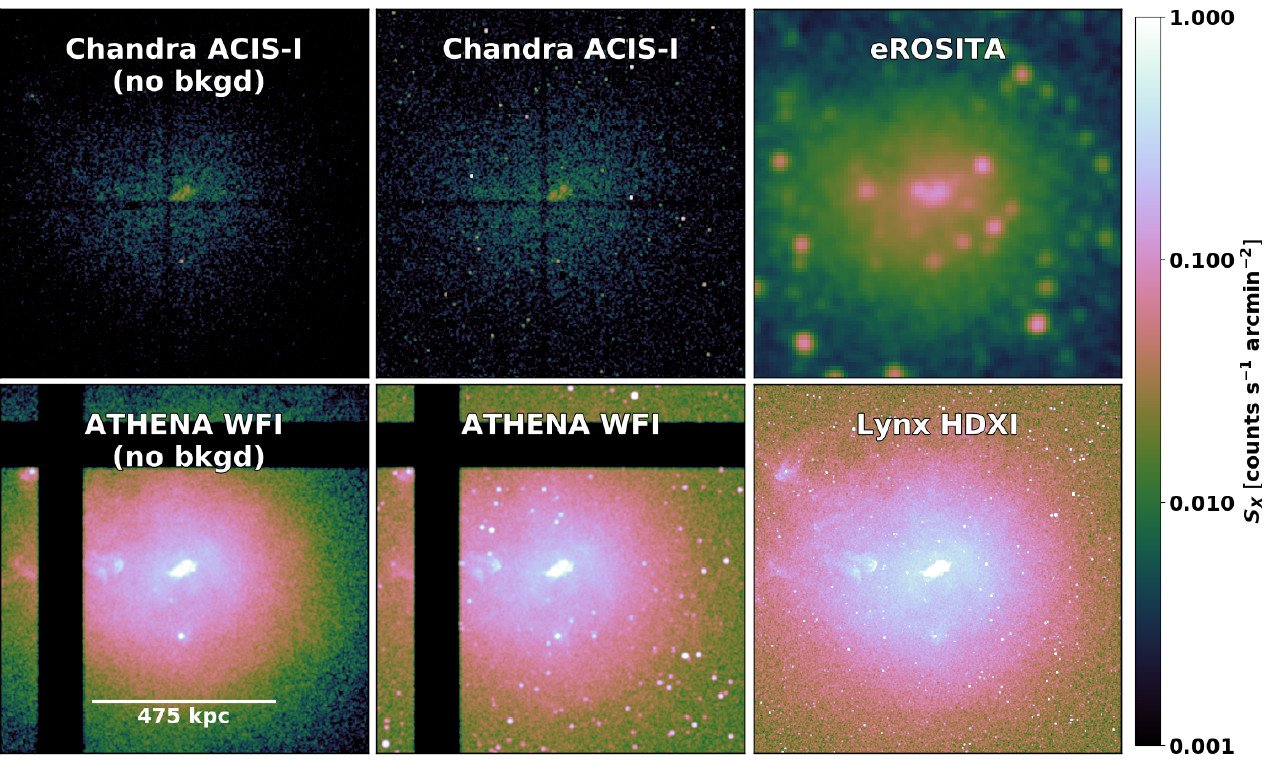
Figure 18. Simulated 100 ksec surface brightness maps of the same TNG100 M 500 = 10 13.6 M CCD detectors on Chandra (Cycle 0 capability), eROSITA , Athena , & Lynx . The two left panels show Chandra and Athena mocks without noise, while all the other panels add noise from the instrument, the Milky Way foreground, and a randomly generated cosmic X-ray background (CXB). The field of view covers out to R 500 . All detectors use the color scale on the right. A. Simionescu collaborated on the production of this figure. Note: the CXB is differently randomly generated in each